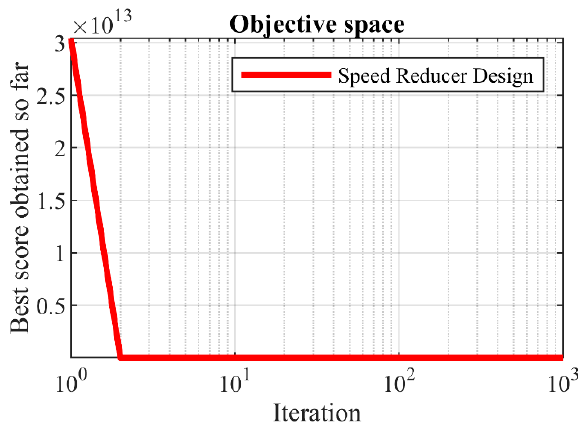
Figure 11. SOA’s performance convergence curve on the speed reducer design.